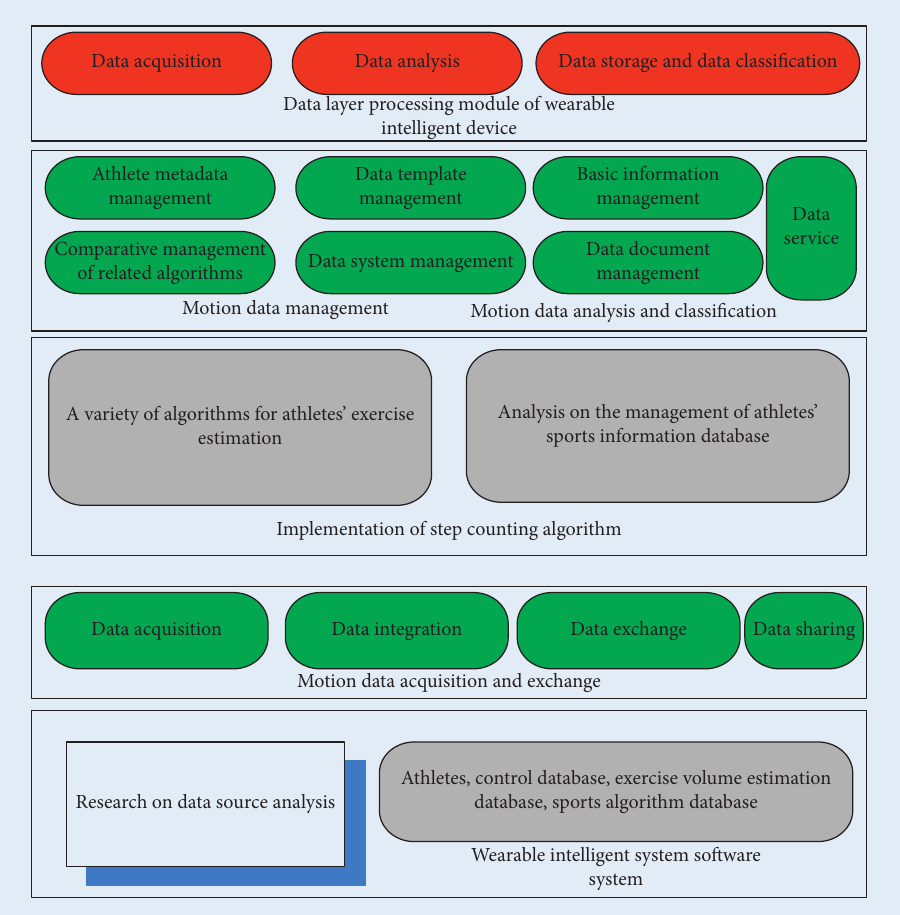
Figure 6: Software system block diagram of wearable intelligent